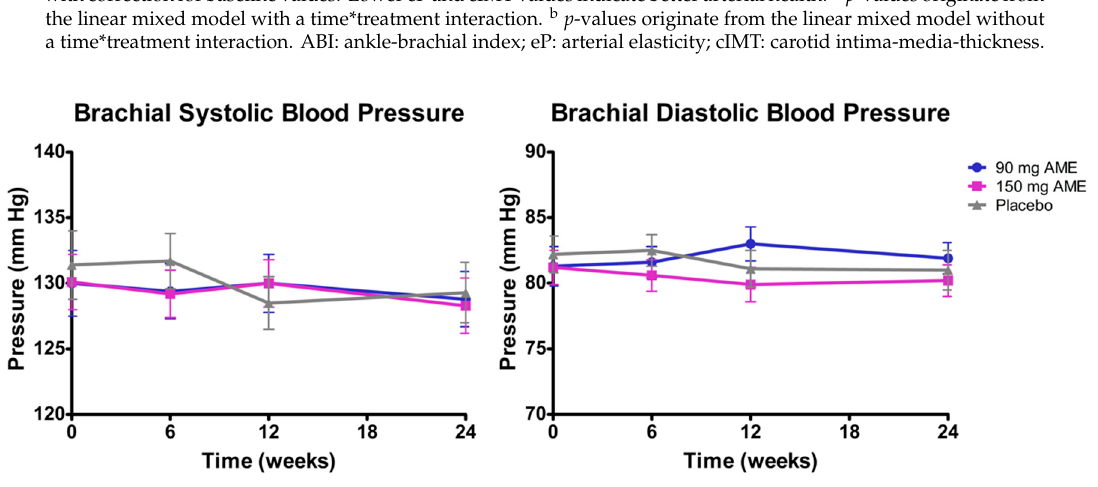
Figure 5. The effect of Aronia melanocarpa extract (AME) supplementation on brachial systolic and diastolic blood pressure. Data are presented as actual mean ± SEM. Analysis was performed with a linear mixed model using estimated means, with correction for baseline values. Post hoc analyses were performed for the factor treatment where applicable.